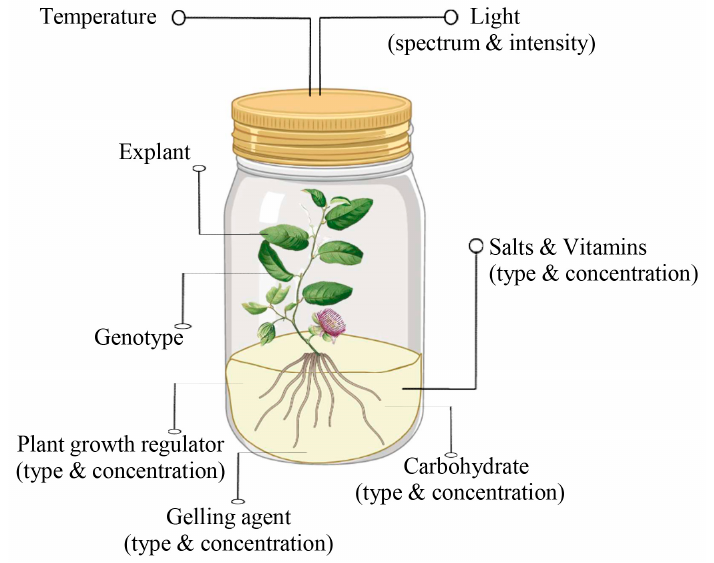
Figure 1. Schematic representation of factors affecting in vitro rooting of P. caerulea .